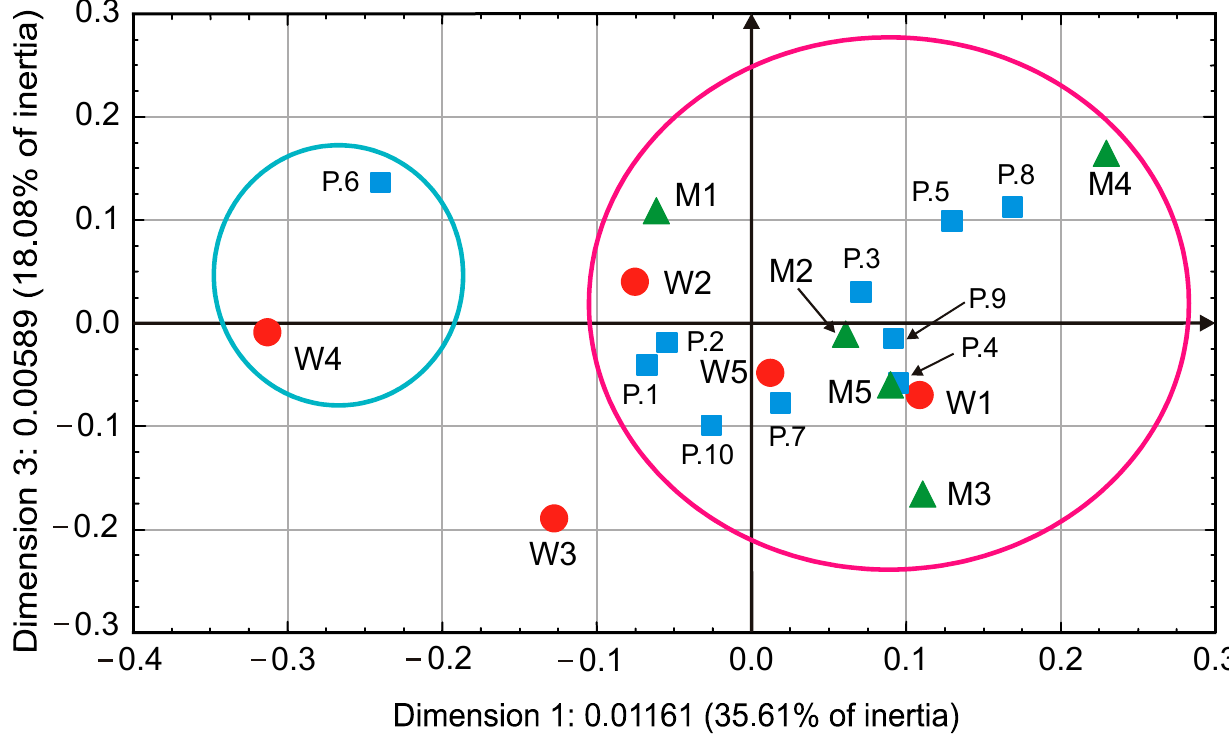
Figure 5. Two dimensional plot of column and row coordinates: dimension 1 × 3. Input table (rows × columns) 10 × 10.